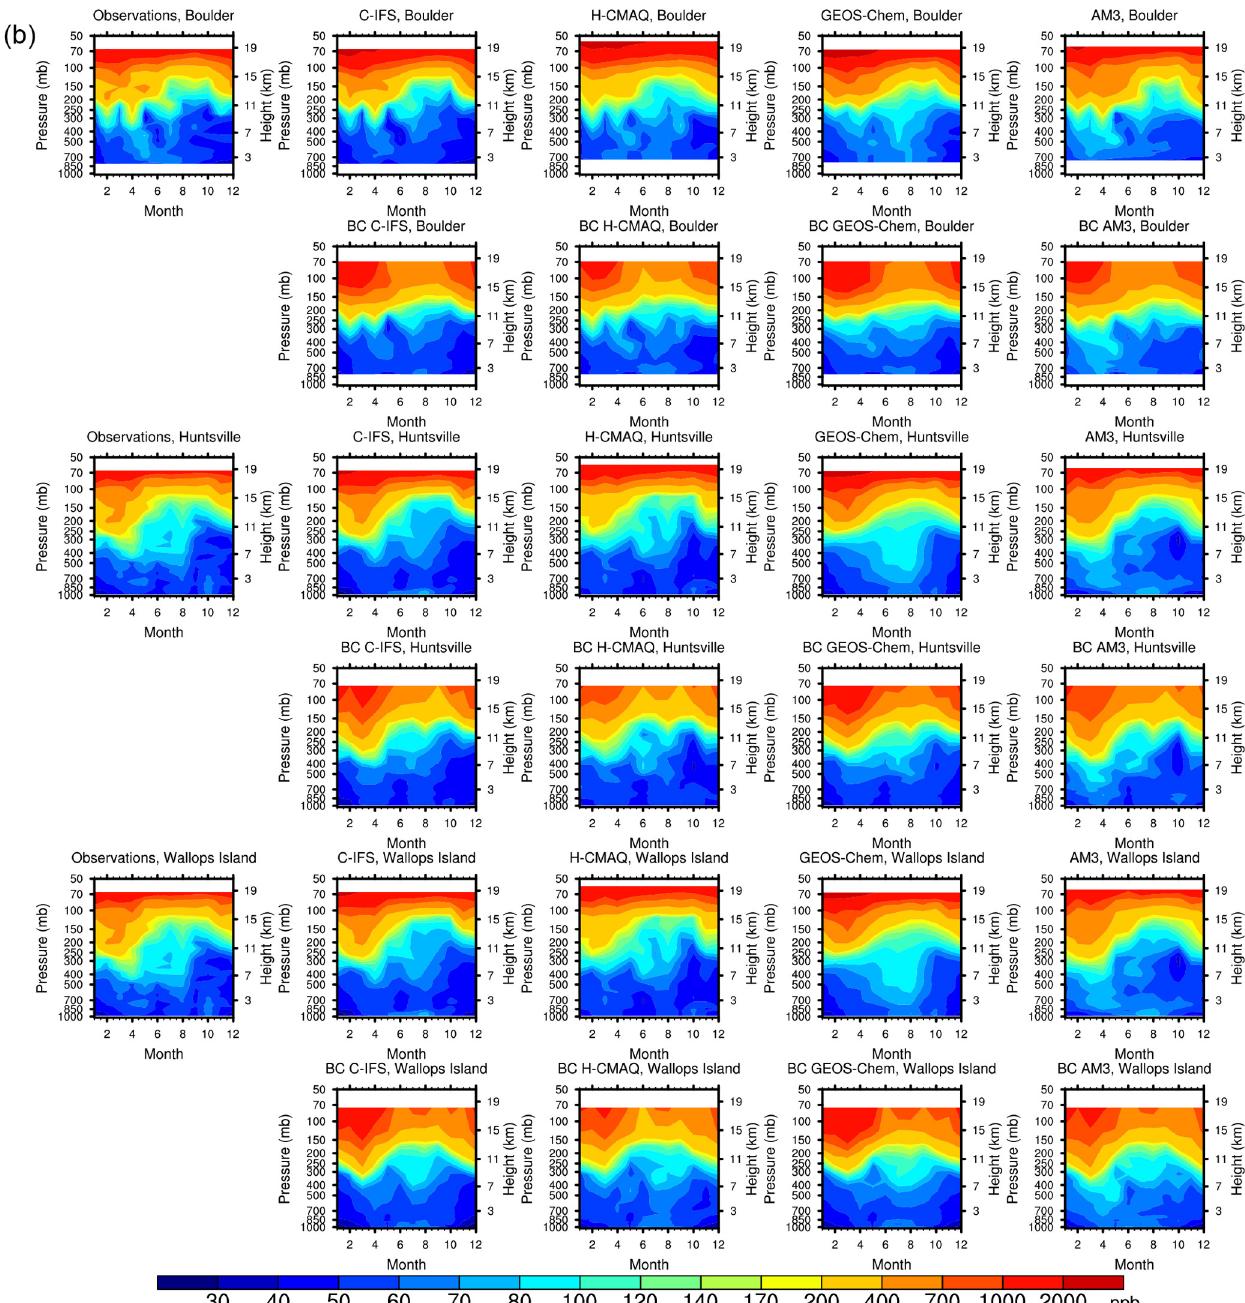
Figure 8. (a) Time–height cross sections of monthly mean ozone mixing ratios for ozonesonde observations (column 1), large-scale models (columns 2–5 in rows 1, 3, and 5), and regional CMAQ simulations (columns 2–5 in rows 2 and 4) at Trinidad Head, Edmonton, and Churchill. Note that no regional CMAQ results are shown for Churchill because the station is located outside the regional model domain. Additional details on the processing of observations and model simulations are provided in the text. (b) Time–height cross sections of monthly mean ozone mixing ratios for ozonesonde observations (column 1), large-scale models (columns 2–5 in rows 1, 3, and 5), and regional CMAQ simulations (columns 2–5 in rows 2, 4, and 6) at Boulder, Huntsville, and Wallops Island. Additional details on the processing of observations and model simulations are provided in the